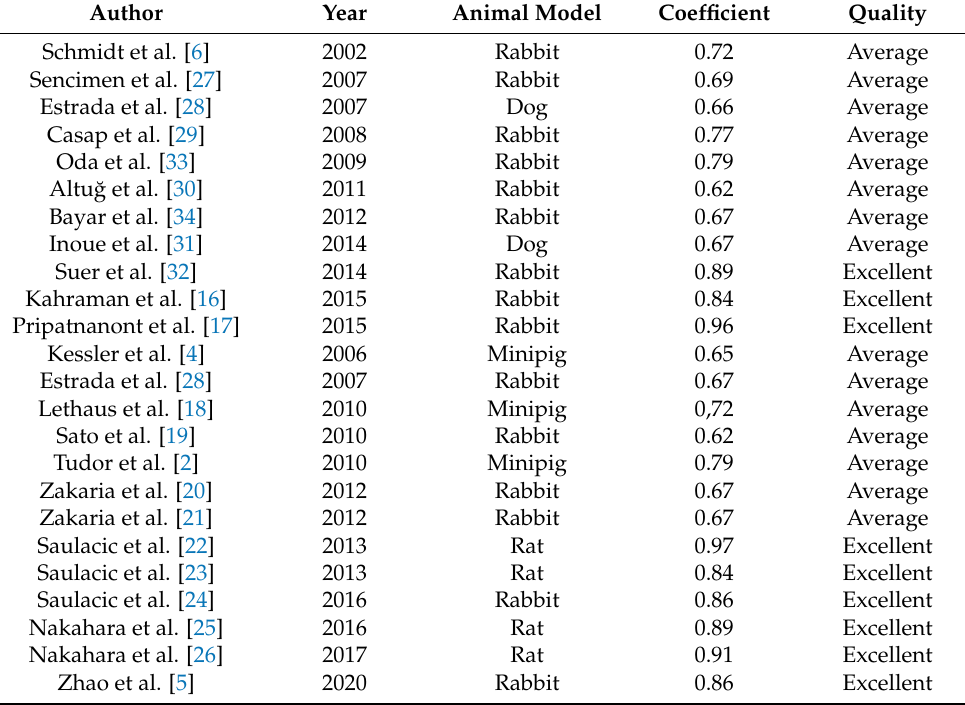
Table 4. Quality coefficients of the studies